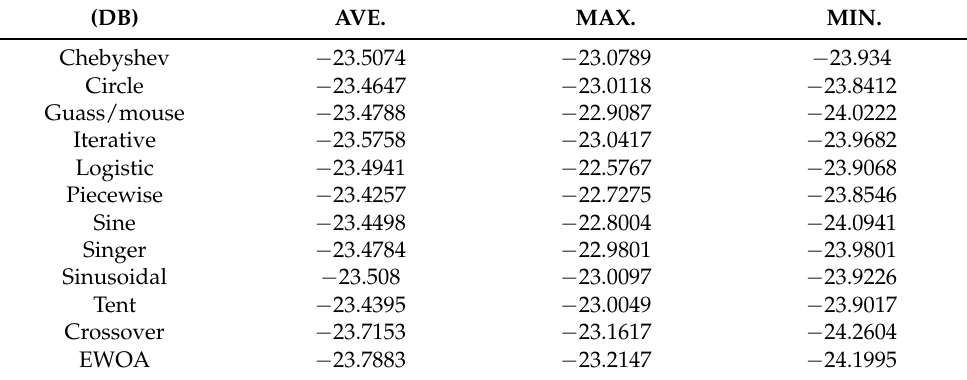
Table 3. Statistical results of the objective values obtained by different improved factors.